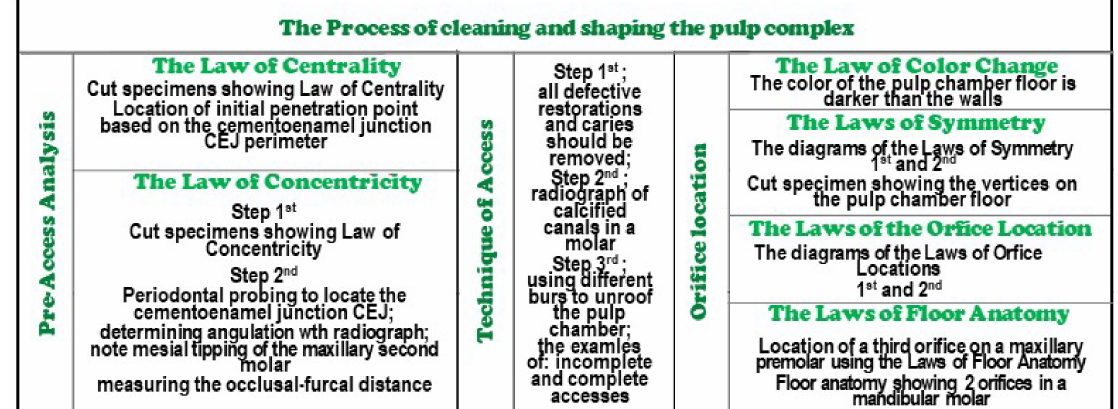
Figure 8. Diagram of the principles of tooth qualification for endodontic treatment based on the analysis of the anatomy of the treated tooth and the surrounding